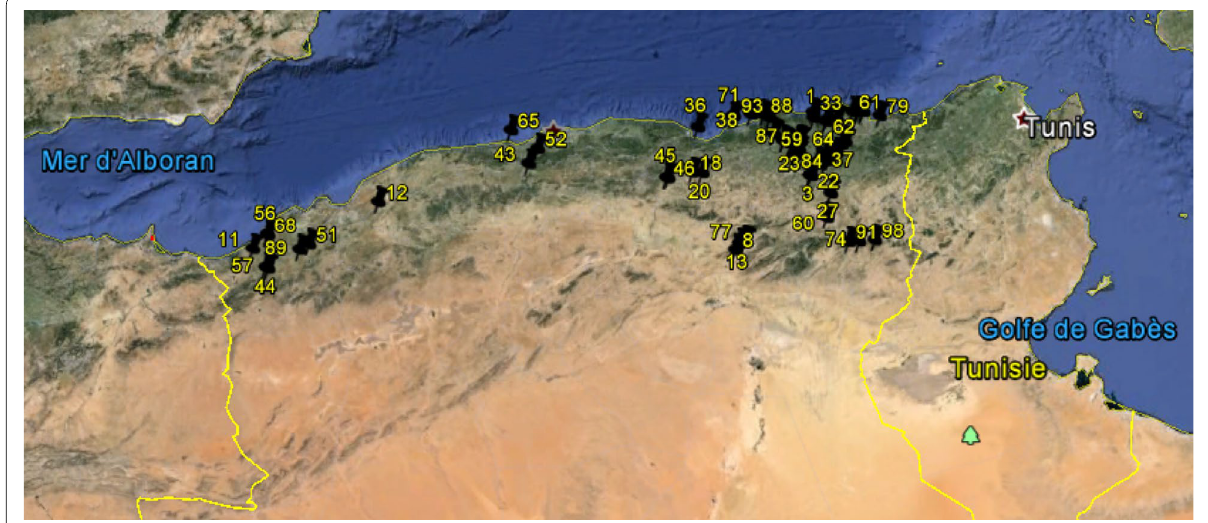
Fig. 1 Geographical origin of the 78 Algerian populations